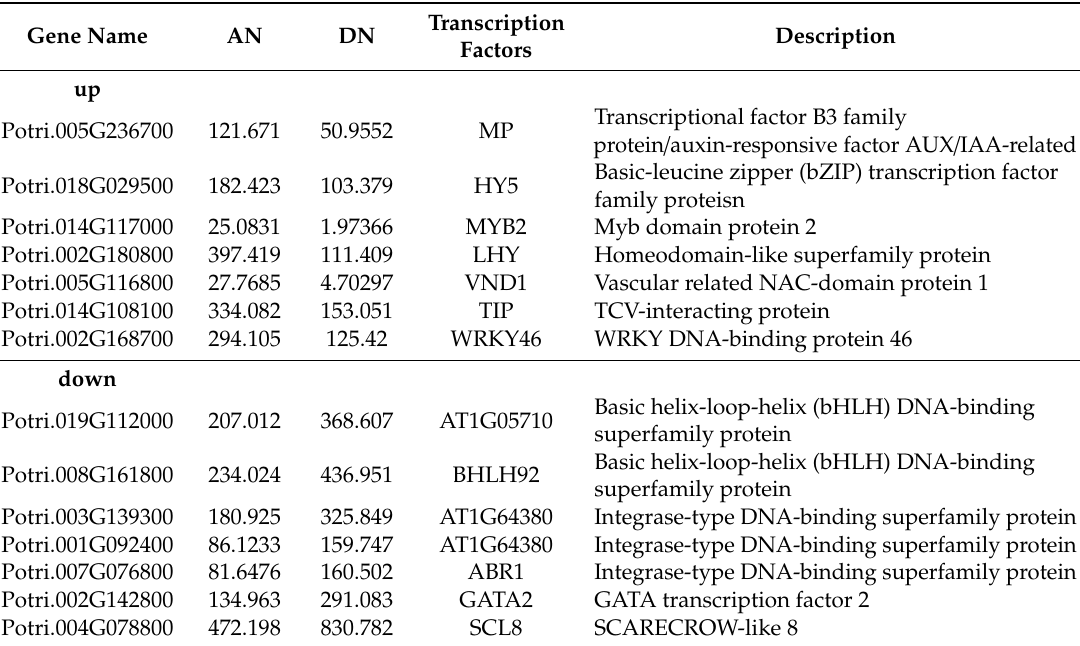
Table 3. Di ff erentially expressed transcription factors at